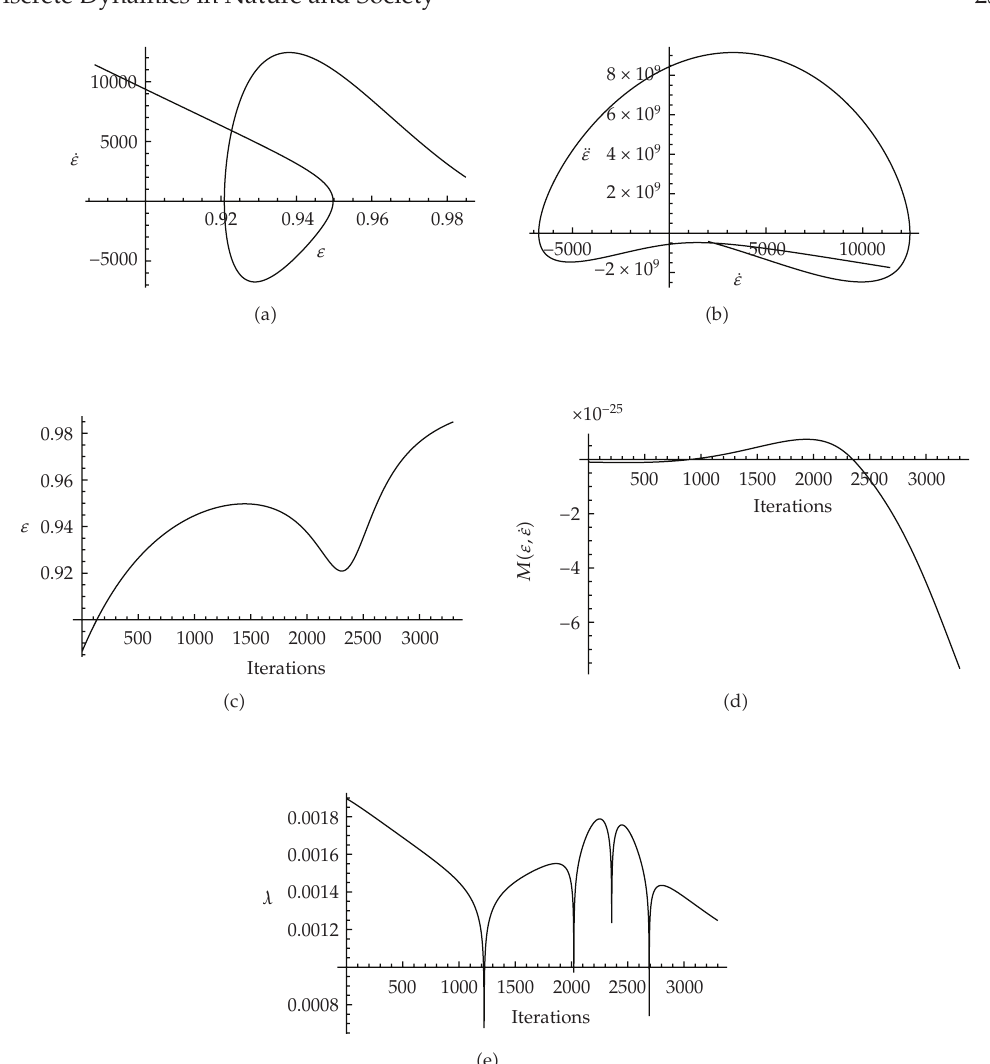
Figure 5: (cid:6) a (cid:7) and (cid:6) b (cid:7) The ε, ˙ ε and the ˙ ε, ¨ ε phase space graphs, respectively. (cid:6) c (cid:7) and (cid:6) d (cid:7) ε and the (cid:6) universal time (cid:7) e ff ective mass M (cid:6) ε, ˙ ε (cid:7) as functions of the number of iterations. As in the previous cycle, the mass fluctuation amplitude grows. (cid:6) e (cid:7) Again, the Lyapunov exponent fluctuates during the cycle and returns to decay as it